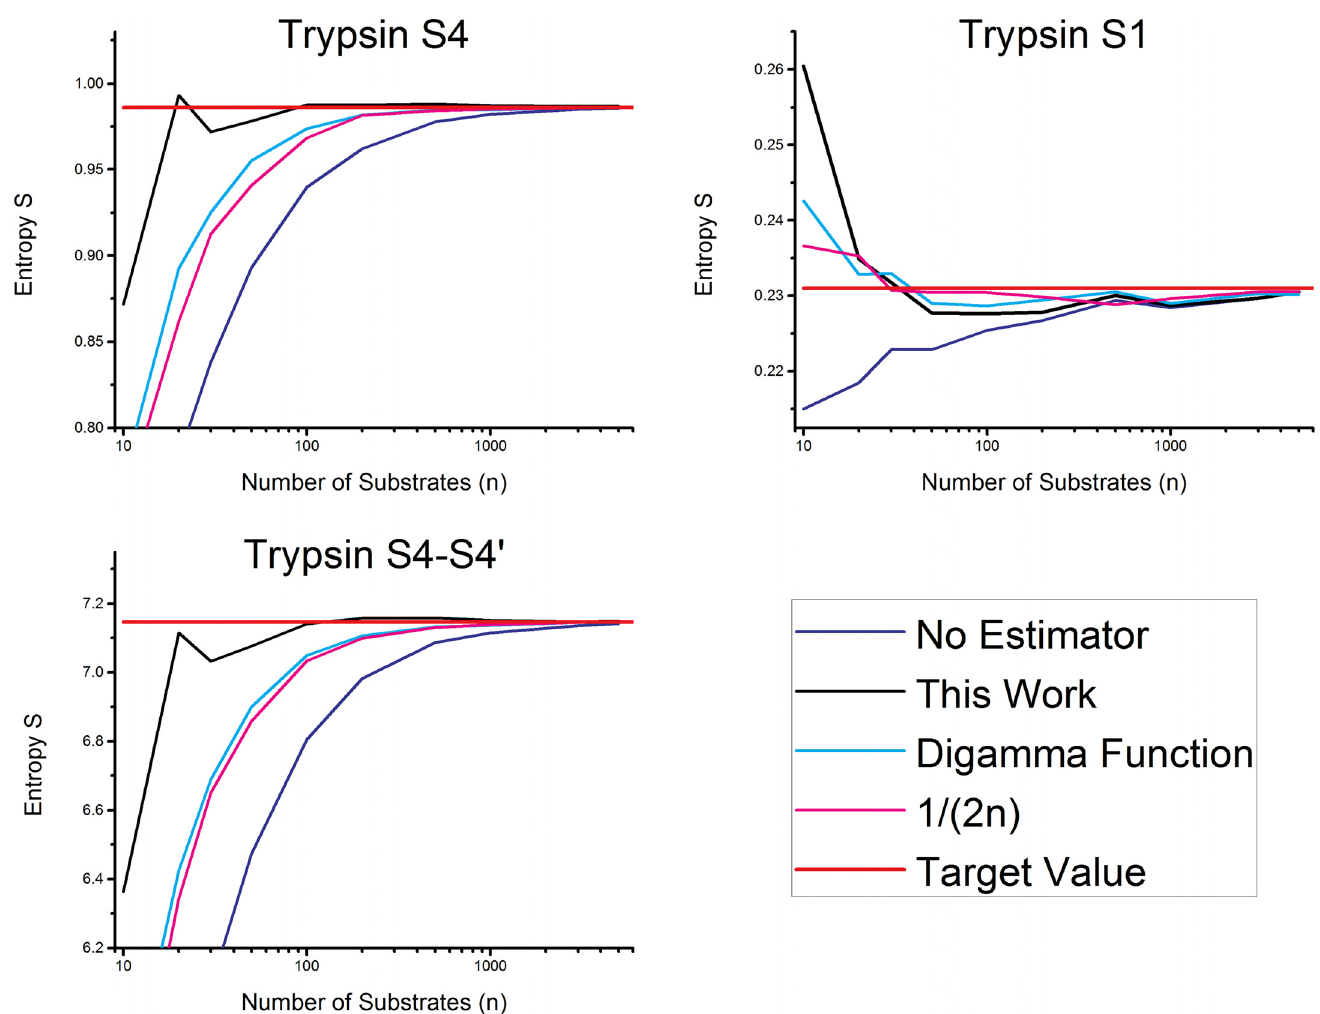
Fig 5. Comparison of the different entropy estimators. The estimation process presented in this work is outperforming the compared published